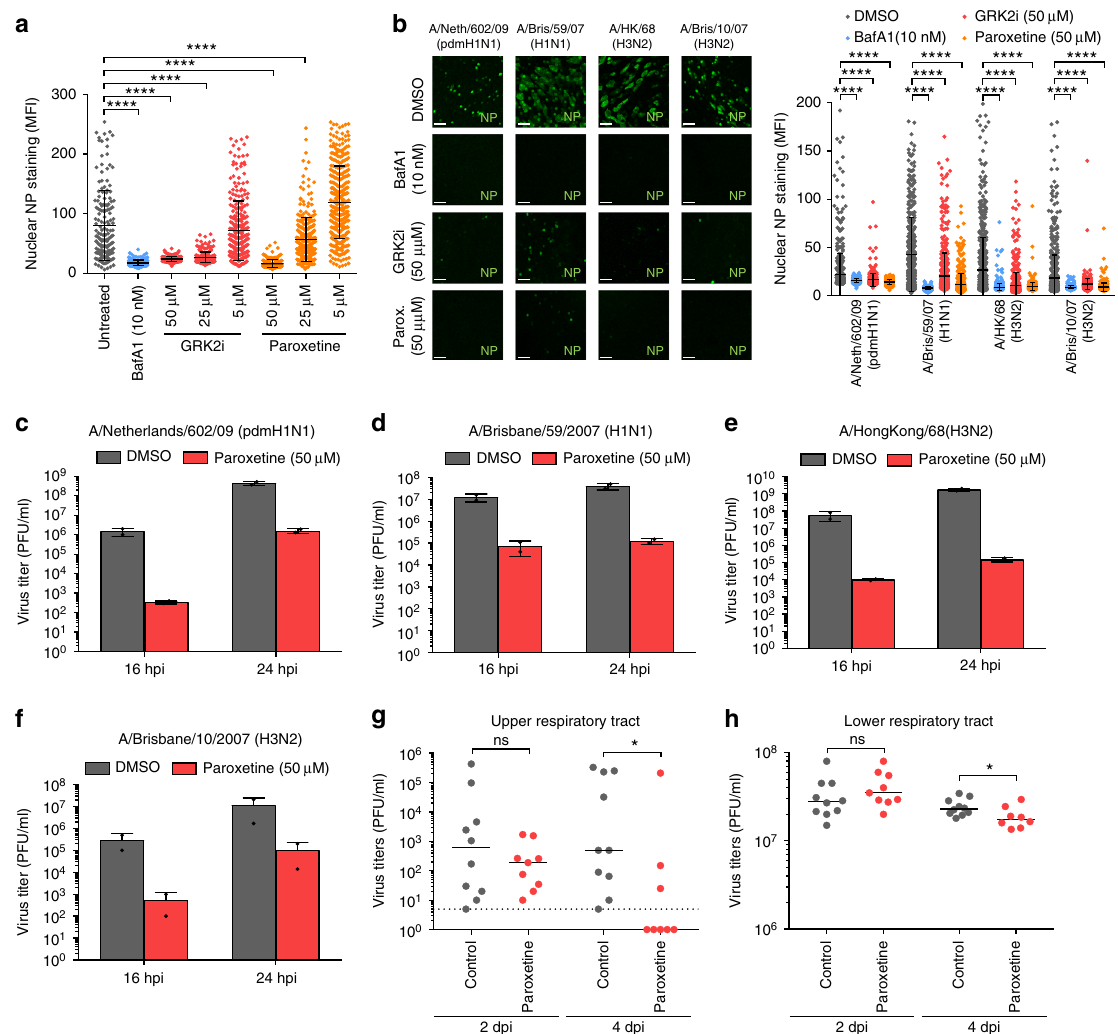
Fig. 5 IAV replication can be limited by the use of GRK2 inhibitors in human airway cultures and in mice. a A549 cells were treated for 1 h with the indicated amounts of the different compounds and infected on ice with IAV A/WSN/33 (H1N1) at an MOI = 5 PFU/cell. Cells were incubated at 37 °C for 3 h in presence of the inhibitors, fi xed and stained for viral nucleoprotein (NP, green) and nuclei (blue). The distribution of NP at the different time-points was analyzed by confocal microscopy and mean fl uorescence intensity (MFI) in the cell nuclei ( n > 200) was quanti fi ed using ImageJ. One representative out of four independent experiments is shown. Statistical signi fi cance was determined by unpaired t -test. b Fully differentiated human airway epithelial (HAE) cultures were infected with the indicated human IAV strains (10 7 PFU/well) in presence of the indicated compounds. Cells were processed and NP nuclear staining was quanti fi ed as described in ( a ). Scale bar corresponds to 40 µ m. One representative out of at least two independent experiments is shown. c – f HAE cultures were infected with the indicated human IAV strains (1000 PFU/well) in presence or absence of paroxetine. At the indicated times post-infection, supernatants were harvested and virus titers were determined by plaque assay. For a – f , error bars represent standard deviation and statistical signi fi cance was determined by unpaired t -test. g , h Virus titers in the upper respiratory tract (URT) and lower respiratory tract (LRT) of mice treated with solvent (gray) or paroxetine (red) and infected with A/Netherlands/602/2009 (pdmH1N1) for 2 and 4 d pi are depicted (two independent experiments, n ≥ 8 per group). Statistical signi fi cance was determined using non-parametric two-tailed Mann – Whitney test. For all panels, ns (non- signi fi cant) = P > 0.05; * P ≤ 0.05; ** P ≤ 0.01; *** P ≤ 0.001; **** P ≤